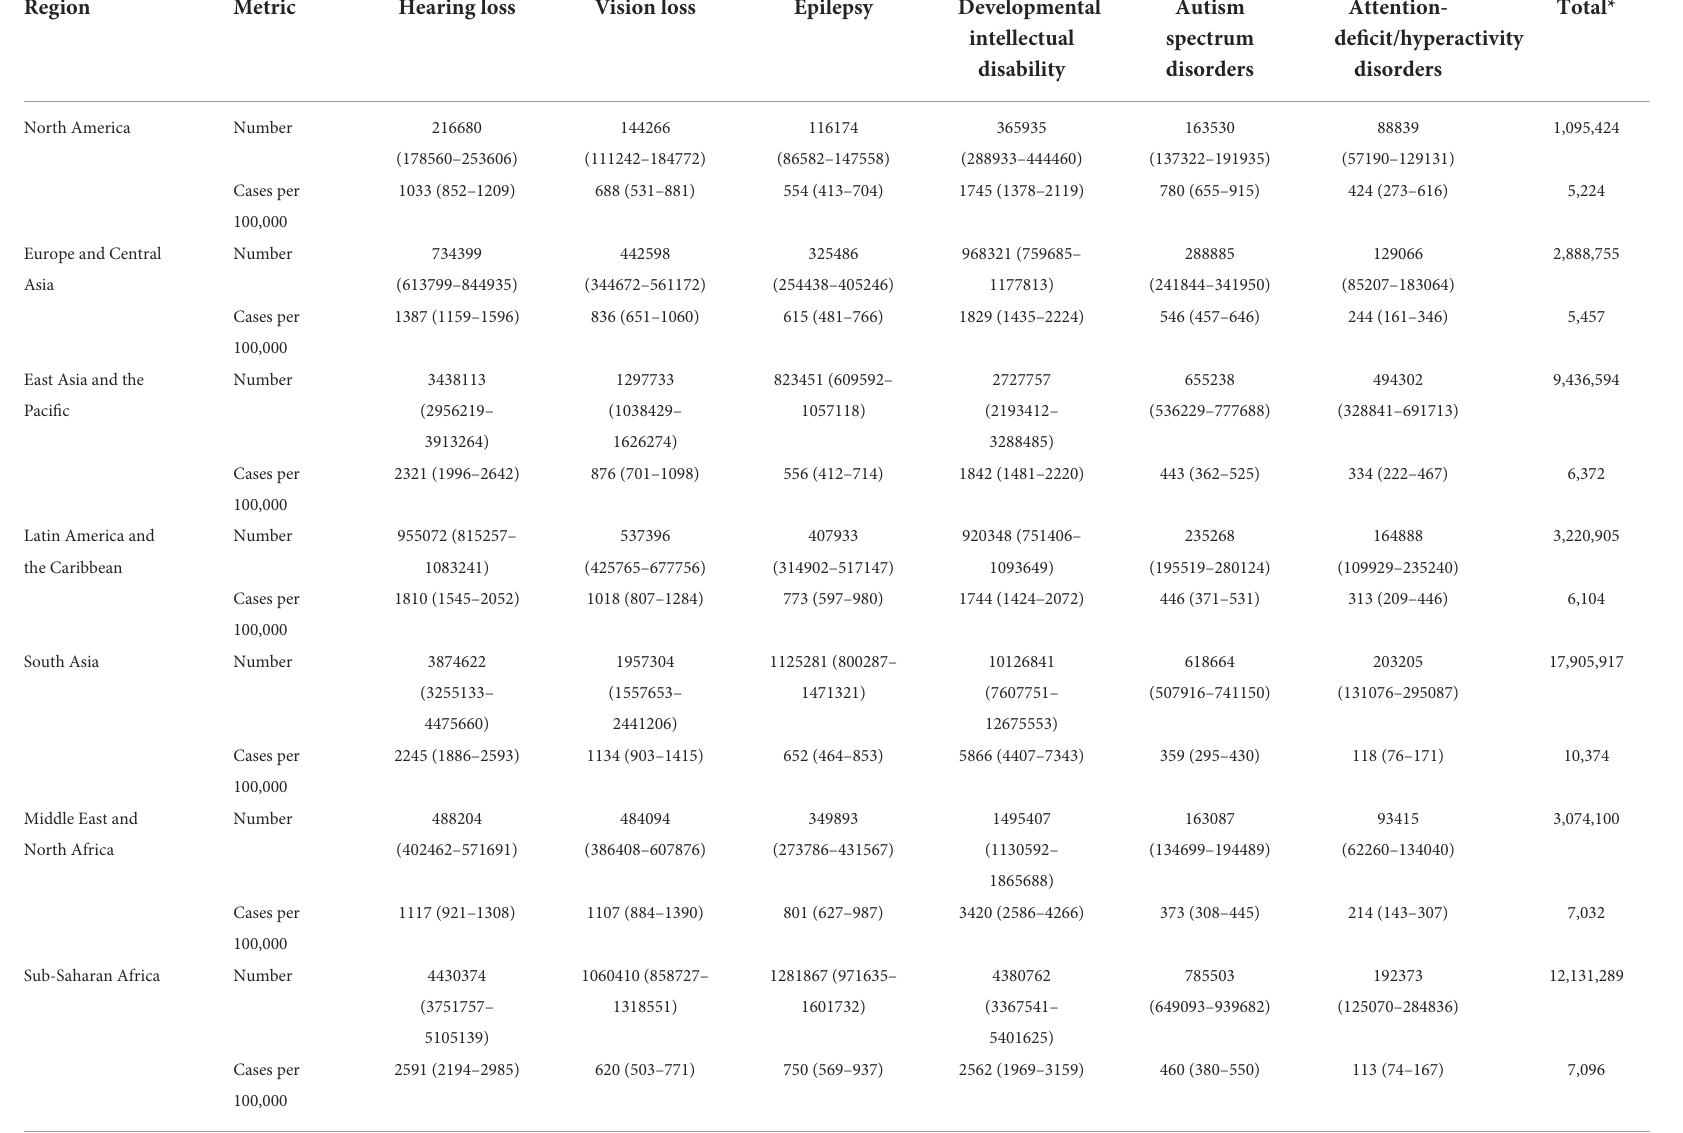
TABLE 3 Global and regional prevalence estimates (95% uncertainty intervals) of disabilities among children younger than 5 years from GBD